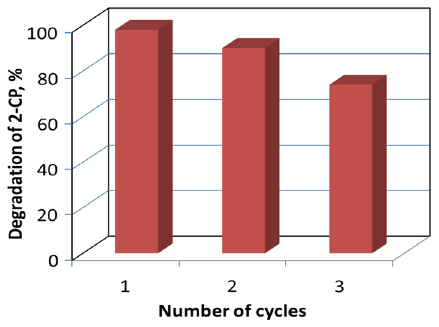
Fig. 7 The stability of TiO